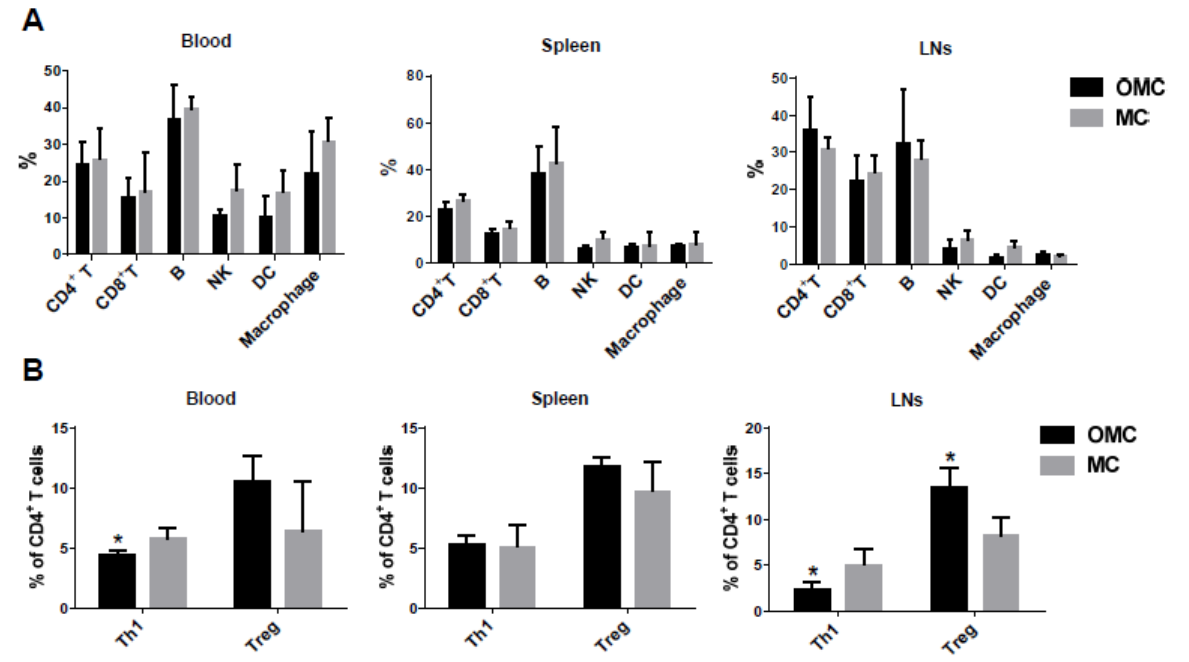
Figure 4. Development of leukocytes in face-allotransplanted mice. ( A ) Profiles of lymphocytes and monocytes in lymphoid organs of face-allotransplanted mice. Percentages of lymphocyte and monocyte subsets in the blood, spleen, and lymph nodes (LNs) of allogeneic osteomyocutaneous (OMC) and myocutaneous (MC) groups were examined using flow cytometry. Immune cells were harvested from lymphoid organs of mice from each group receiving 0.6 mg/kg of FK506 on POD 14. The immune cells were stained for cluster of differentiation (CD)4 + T and CD8 + T, CD19 + B, NK1.1 + nature killer cells (NKs), CD11c + dendritic cells (DCs), CD11b + macrophage cells. T, B, and NKs were gated from lymphocytes, and DCs and macrophages were gated from lymphocytes and monocytes for flow cytometry analysis. Data were collected from three mice in each group. The statistical data are presented as mean ± standard deviation (SD). ( B ) Profiles of pro-inflammatory T helper (Th)1 and anti-inflammatory regulatory T (Treg) cells in lymphoid organs of face-allotransplanted mice. Percentages of pro-inflammatory Th1 and anti-inflammatory Treg cell subsets in the blood, spleen, and lymph nodes of allogeneic OMC and MC groups were analyzed using flow cytometry. Lymphocytes were isolated from lymphoid organs of mice from each group receiving 0.6 mg/kg of FK506 on POD 14 for CD4 + T cell subset analysis. The immune cells were stained for CD4 + IFN- γ + (interferon gamma) Th1 and CD4 + CD25 + FoxP3 + (Forkhead box P3) Treg cells. Data were collected from three mice in each group. The statistical data are presented as mean ± SD. The allogeneic OMC group was compared with the MC group for each lymphoid organ (* p < 0.05, Student’s t test).